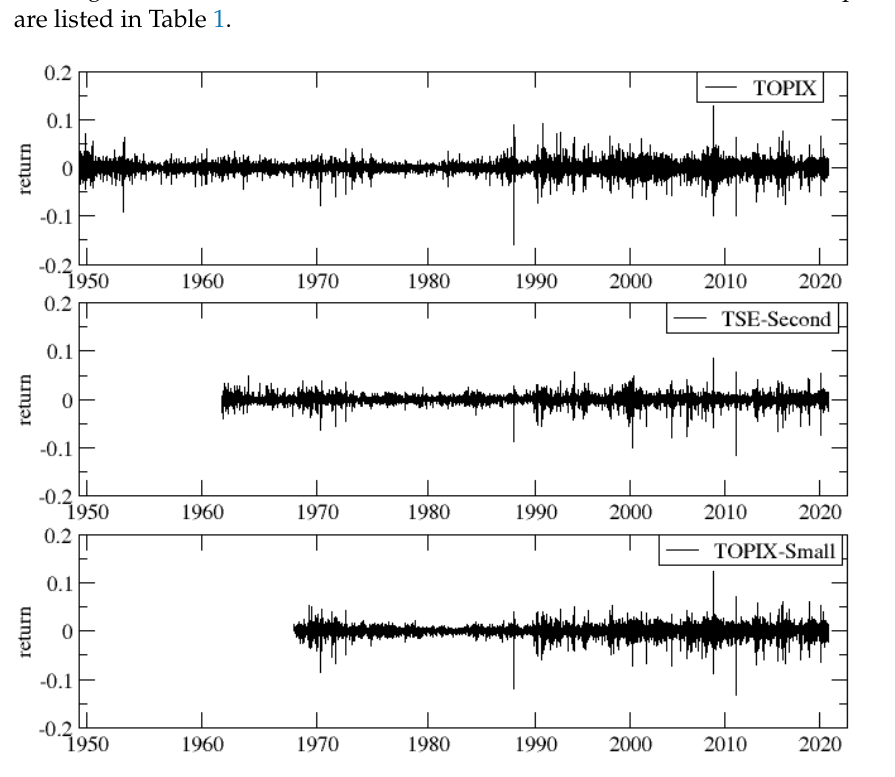
Figure 1. Return time series of the three indices ( top ) Topix, ( middle ) TSE-Second, and ( bottom )